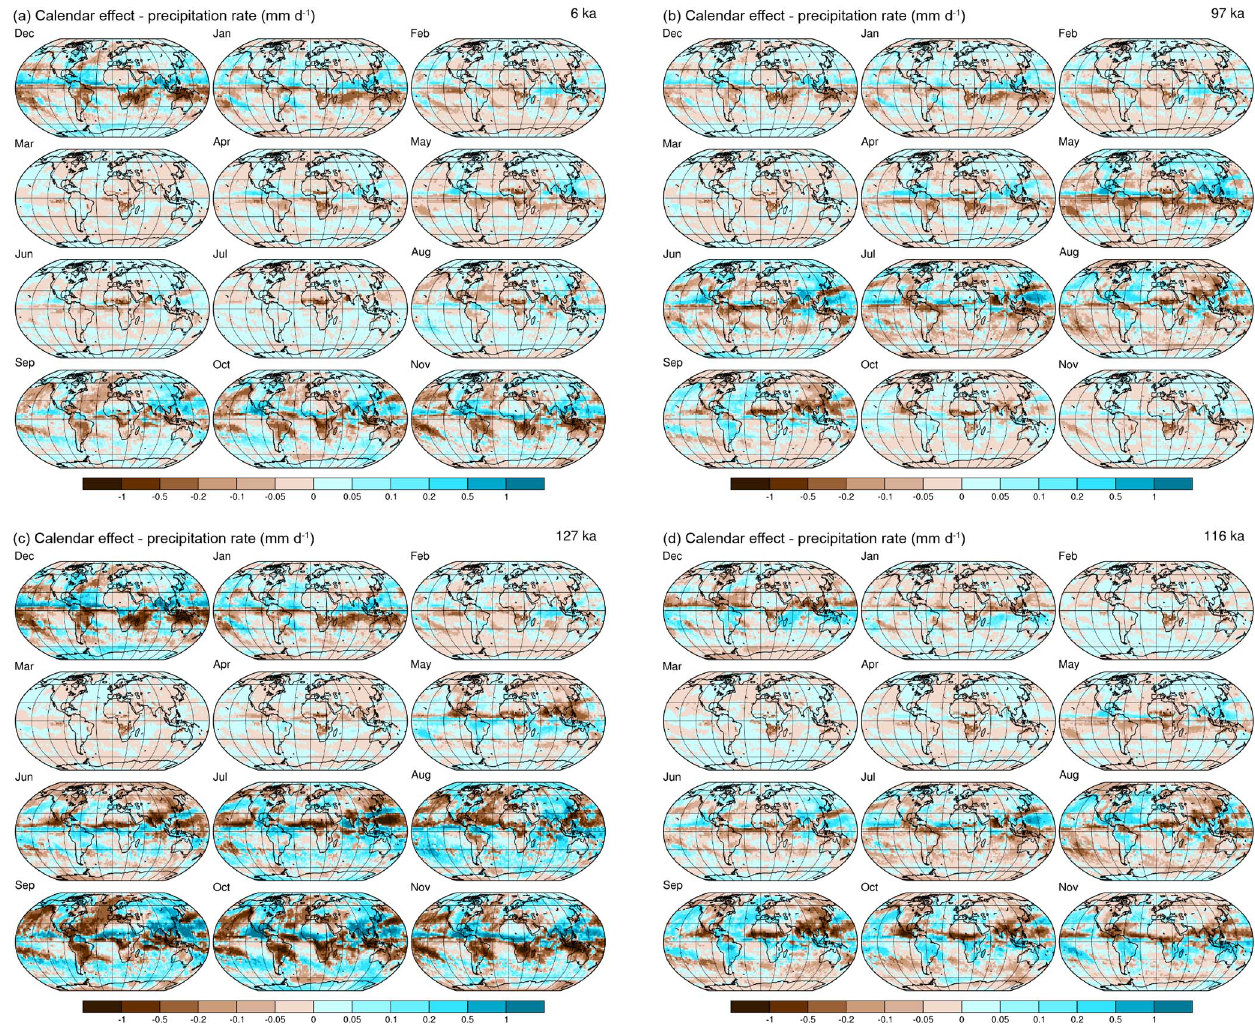
Figure 13. Calendar effects on precipitation rate for 6ka (a) , 97ka (b) , 127ka (c) , and 116ka (d) . The maps show the patterns of month- length adjusted precipitation rate minus the unadjusted values using 1981–2010 long-term averages of CMAP precip values, with positive differences (indicating that the adjusted data would be wetter than unadjusted data) in blue hues and negative differences in